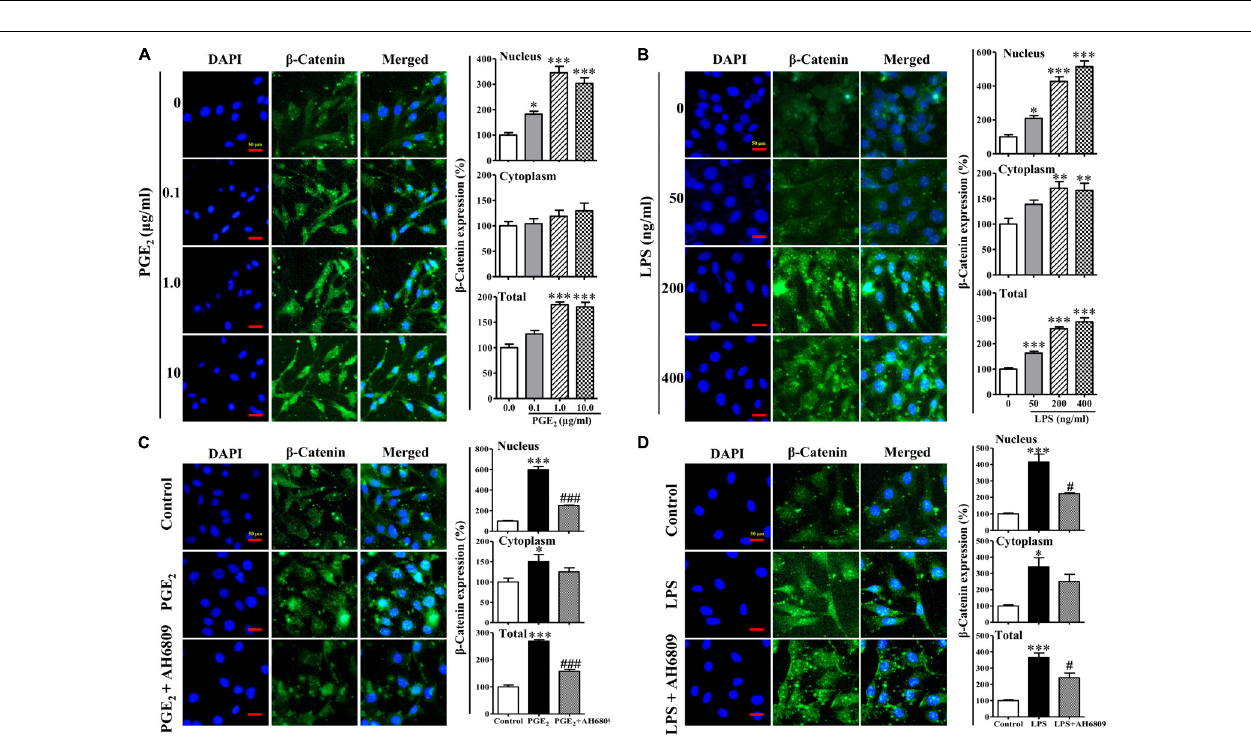
FIGURE 7 | The nuclear translocation of β -catenin induced by prostaglandins E 2 (PGE 2 ) and LPS. The NIH3T3 cells were plated on µ -slides with eight wells and incubated with PGE 2 (A) , LPS (B) , PGE 2 (1 µ g/mL) + AH6809 (1 µ g/mL) (C) , or LPS (400 ng/mL) + AH6809 (1 µ g/mL) (D) for 24 h. Fluorescence of the β -catenin expression was quantified by image analysis software (NIS-Elements AR 3.0, Nikon). Scale bars: 50 µ m. ∗ P < 0.05, ∗∗ P < 0.01, and ∗∗∗ P < 0.001 vs. control; # P < 0.05 vs the LPS group in (D) ; ### P < 0.001 vs the PGE2 group in (C) , n =